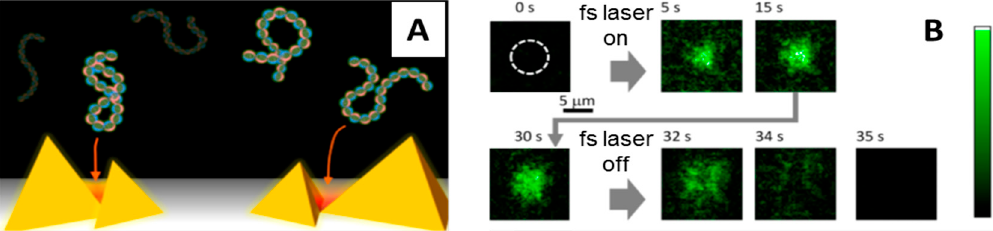
Figure 4. ( A ) Illustration showing gold nanopyramidal dimers and DNA molecules being trapped in plasmonic traps (red areas). ( B ) Fluorescence micrographs showing assembly of λ -DNA molecules stained with YOYO-1 in the area of the plasmonic substrate irradiated with the femtosecond (fs) laser (dashed white circle). As the fs laser is turned on, the irradiated area becomes brighter and brighter over time as an increasing number of molecules are trapped. When the laser is turned off the molecules go back in solution. Adapted with permission from [75]. Copyright 2013 American Chemical Society.